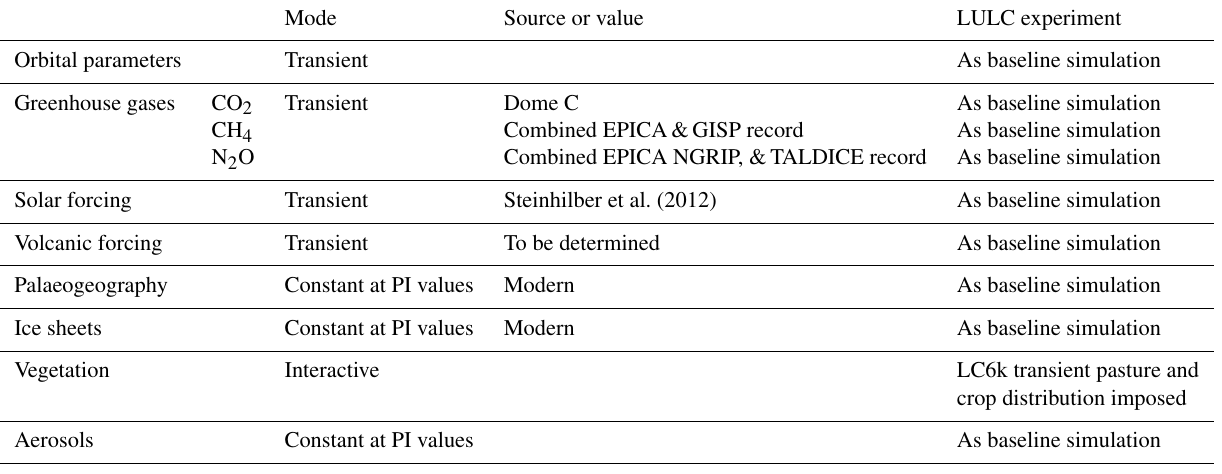
Table 2. Boundary conditions for baseline PMIP Holocene transient (6kaBP to 1850CE) and LULC transient simulations.